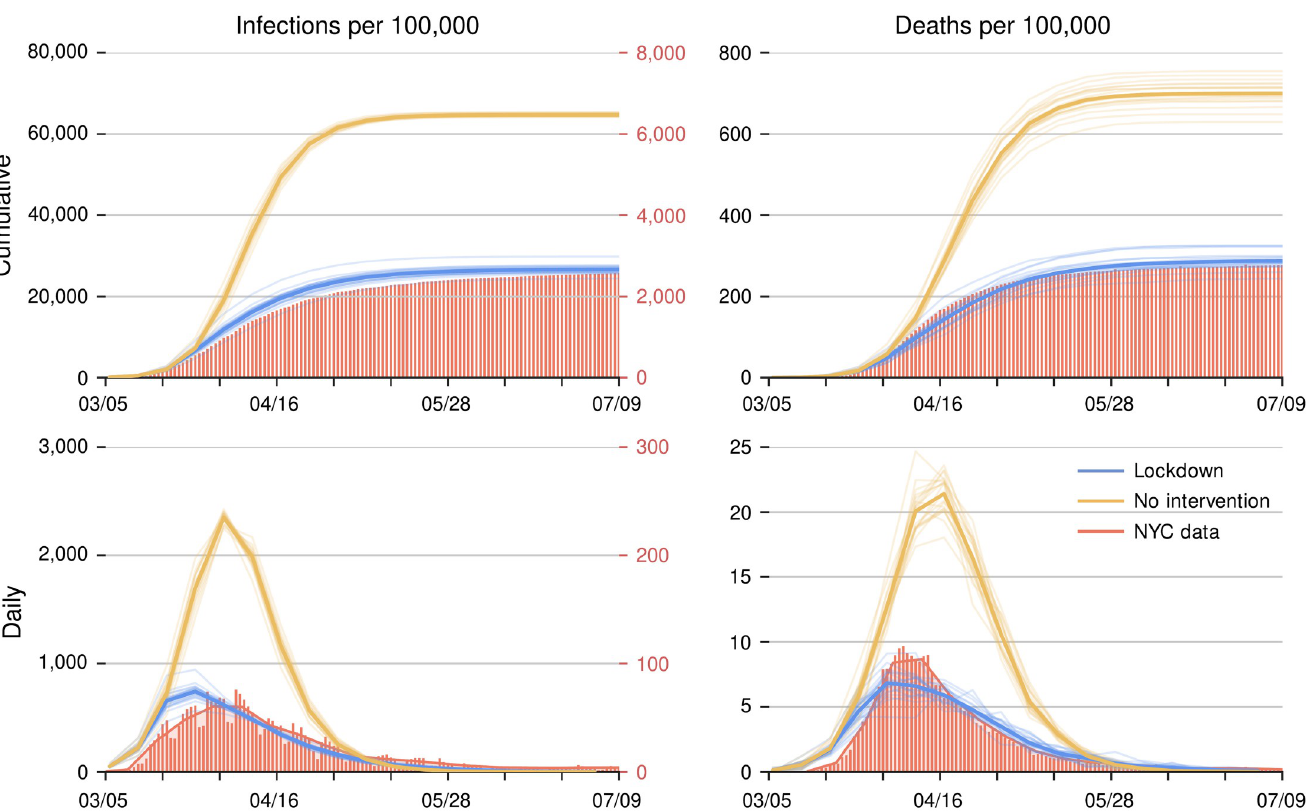
Fig 2. Evolution of an outbreak in surrogate-world simulations with a lockdown (blue) and without (orange). The left column shows infection rates and the right column death rates. Upper row for cumulative counts and lower row for daily counts, smoothed with a 7-day moving average filter. Red bars represent confirmed and probable COVID-19 deaths and confirmed infection rates for New York City [36], with the red axis labels on the right for confirmed infection counts. Solid lines indicate the corresponding counts in the simulations, with the black axis labels on the left for infections on the network. (The axes for infections in the simulations are stretched by a factor 10 relative to the axes for confirmed NYC infections, reflecting the undercount of infections by confirmed cases [37]). The light lines show 20 simulations that only differ by random seeds, with the thicker lines indicating the ensemble mean; thus, they give an indication of sampling variability. The average contact rate for all nodes is reduced by 58% from March 25, 2020 onward to mimic the lockdown effect (blue solid